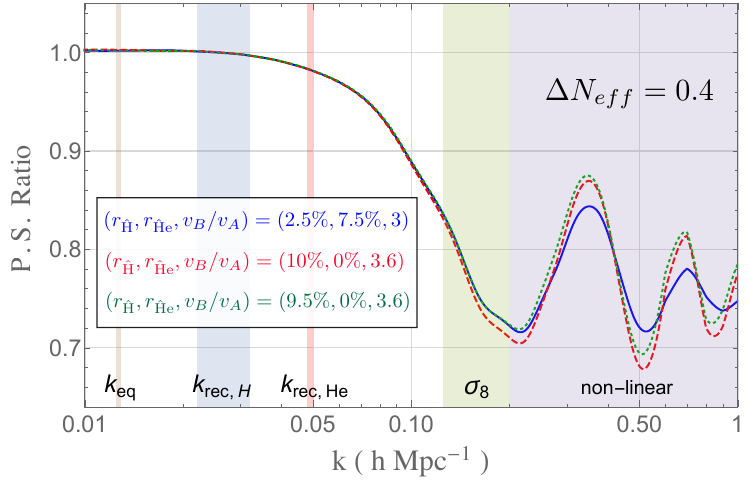
Figure 7 . Ratio of the matter power spectra between (cid:3)CDM+MTH and (cid:3)CDM+DR, for three di(cid:11)erent abundances of mirror H and He. The blue curve considers r all = 0 : 1 with Y ^He = 0 : 75, which is close to the value from the full MTH scenario studied in section 2.2. The red dashed curve corresponds to the hydrogen-only scenario, again with r all = 0 : 1, but with a larger value of v b =v A corresponding to a heavier mirror electron. We see that this gives a good (cid:12)t to the MTH result for k < 0 : 12 h Mpc (cid:0) 1 , but the two curves begin to exhibit di(cid:11)erences in the (cid:27) 8 region. (cid:24) However, since the blue and red curves correspond to the same r all for the blue and red curves the average suppression for large k -modes is the same, as discussed in eq. (3.15). The green dotted curve corresponds to values of r all and v b =v A that have been chosen to mimic as closely as possible the blue curve in the linear regime, k < 0 : 2 h Mpc (cid:0) 1 . However, since r all di(cid:11)ers from 0 : 1, the (cid:24) average suppression for large k -modes deviates from the blue curve. The percent level di(cid:11)erences between the blue and red curves at k 0 : 2 h Mpc (cid:0) 1 and between the blue and green curves at (cid:25) k > 0 : 2 h Mpc (cid:0) 1 may allow future matter power spectrum measurements to distinguish the MTH from theories with a single species of dark